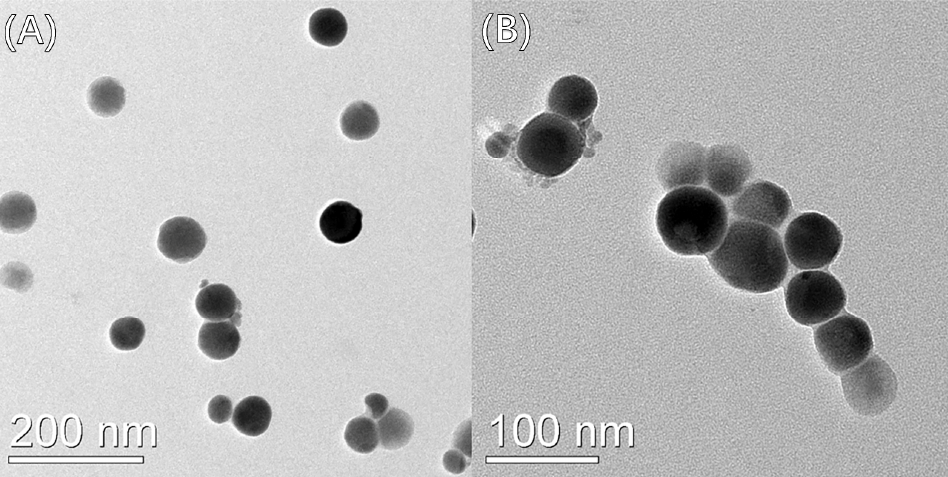
Figure 4. TEM photograph of Se-MOP. ( A ) Magnification: 30,000.0 × Beam: 200.0 kV. ( B ) Magnifica- tion: 50,000.0 × Beam: 200.0 kV.